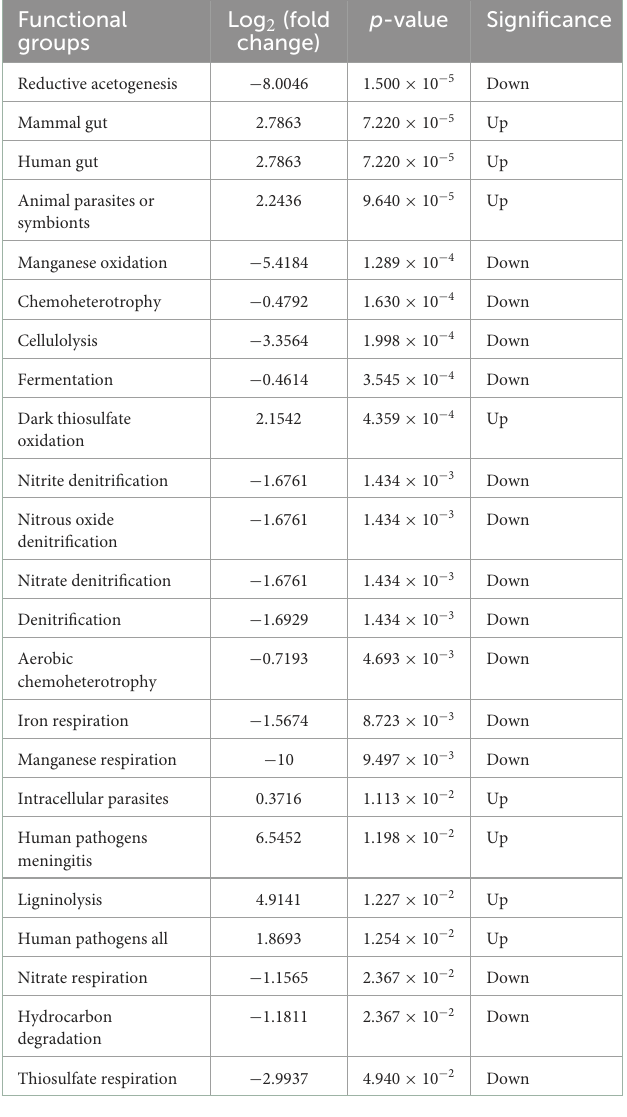
TABLE 1 Predicted composition of functional groups by FAPROTAX and Wilcoxon rank-sum test in captive (C) and wild (W) groups. Functional